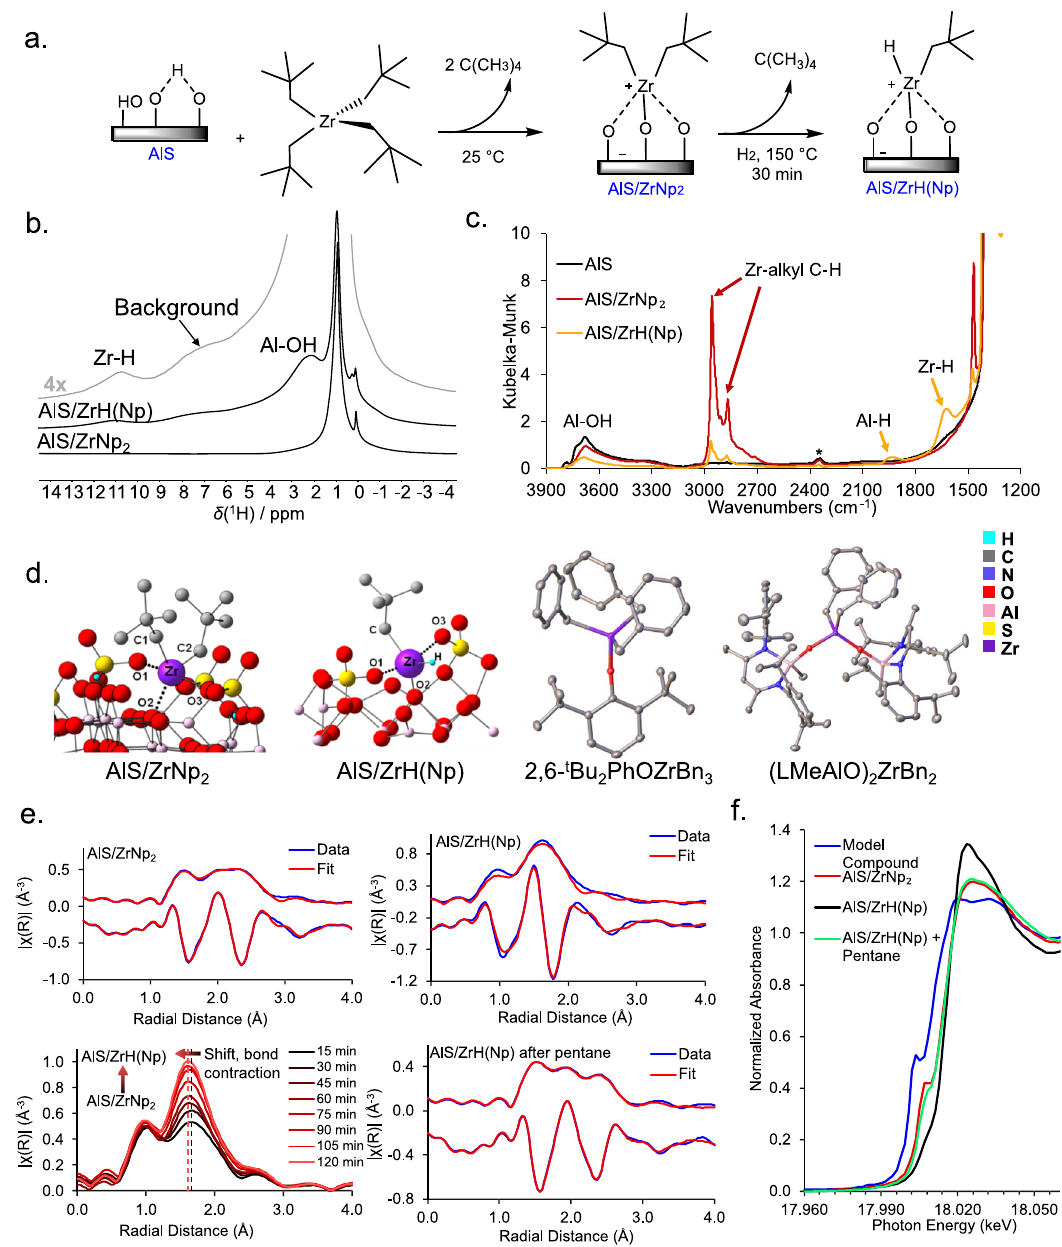
Fig. 5 | Characterization of the AlS/ZrNp 2 adsorbate and AlS/ZrH(Np) hydro- genolysis product;atomisticmodelsofZrdialkyl and alkyl hydride structures on AlS vs. neutrally charged model Zr dialkyls. a Zr(neopentyl) 4 chemisorption on very Brønsted acidic sulfated alumina (AlS), and hydride generation via Zr- neopentylhydrogenolysis. b Solid-state 1 HMAS-NMRspectraofAlS/ZrNp 2 andAlS/ ZrH(Np). c DRIFTS vibrational spectra of AlS/ZrNp 2 , AlS/ZrH(Np), and the AlS support. *Atmospheric CO 2 background artifact. d DFT-computed structures of